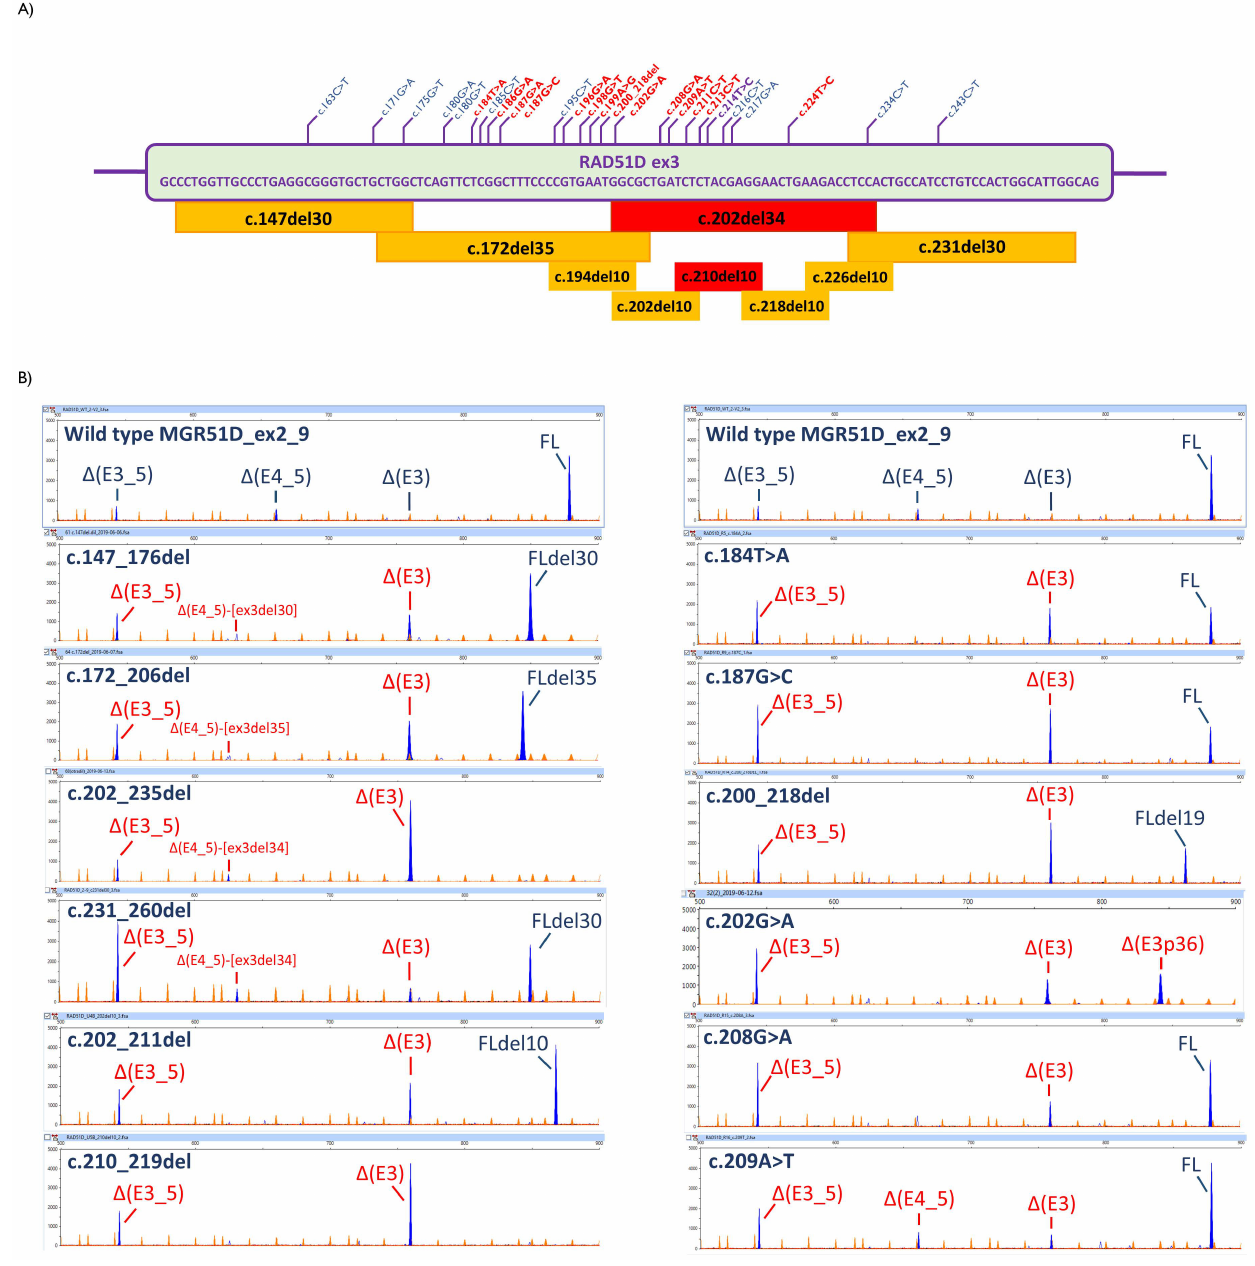
Figure 2. Analysis of RAD51D exon 3 variants. ( A ) Map of exon 3 microdeletions and tested variants. Boxes: red, total splicing disruptions; yellow, weak to moderate disruptions. Spliceogenic variants are shown in red. ( B ) Fluorescent fragment analysis of transcripts generated by selected microdeletions (left) and variants (right). FAM-labeled products (blue peaks) were run with LIZ-1200 (orange peaks) as the size